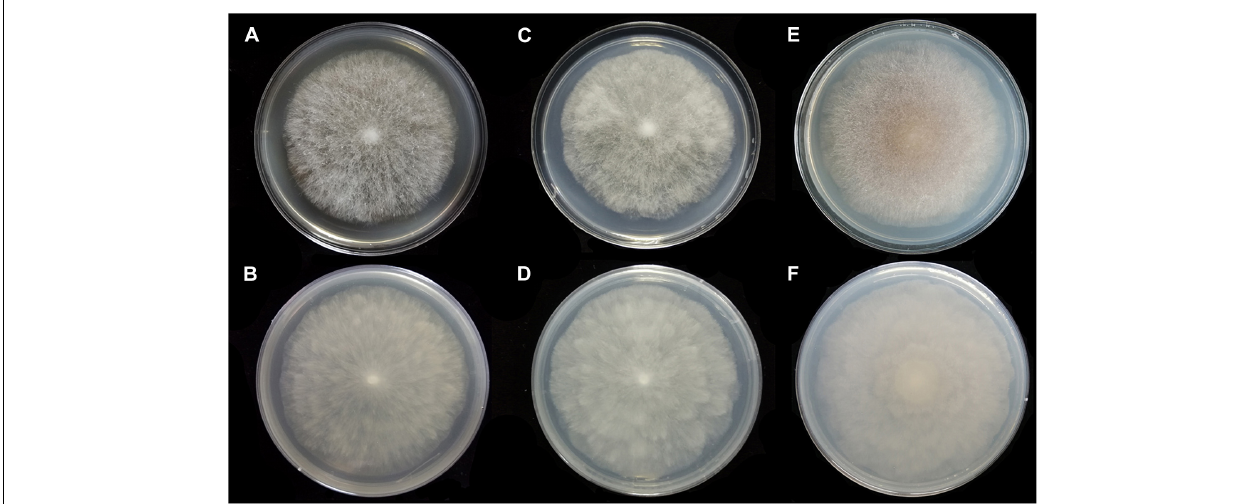
FIGURE 6 | Colonies of Absidia medulla CGMCC 3.16034 at 27 ◦ C after 5 days on MEA (A) obverse, (B) reverse; on SMA (C) obverse, (D) reverse; after 7 days on PDA (E) obverse, and (F) reverse.